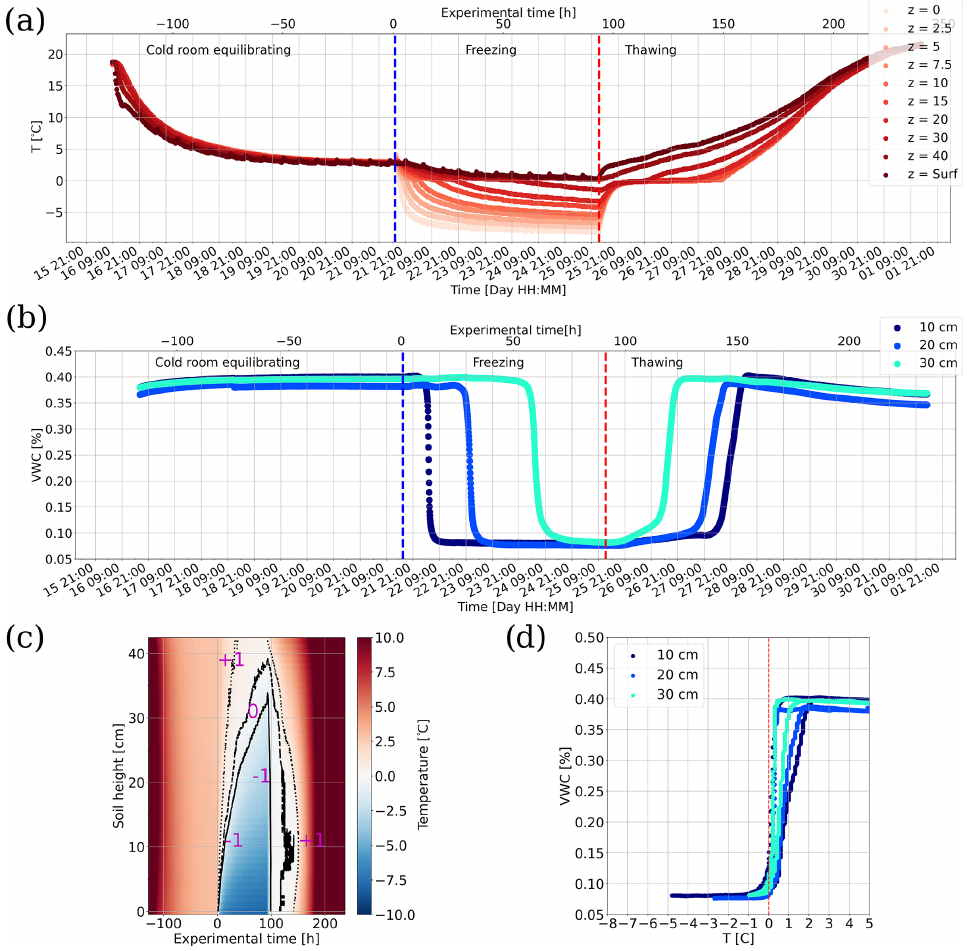
Figure 2. Temperature and volumetric water content monitoring of the experiment: (a) thermal monitoring, (b) volumetric water content monitoring, (c) reconstructed two-dimensional temperature column, (d) soil-freezing curves. Depth of the sensors are in centimetres from the base of the sand layer. Dashed blue line represents the start of the freezing phase, while the dashed red line represents the end of the freezing phase and the beginning of